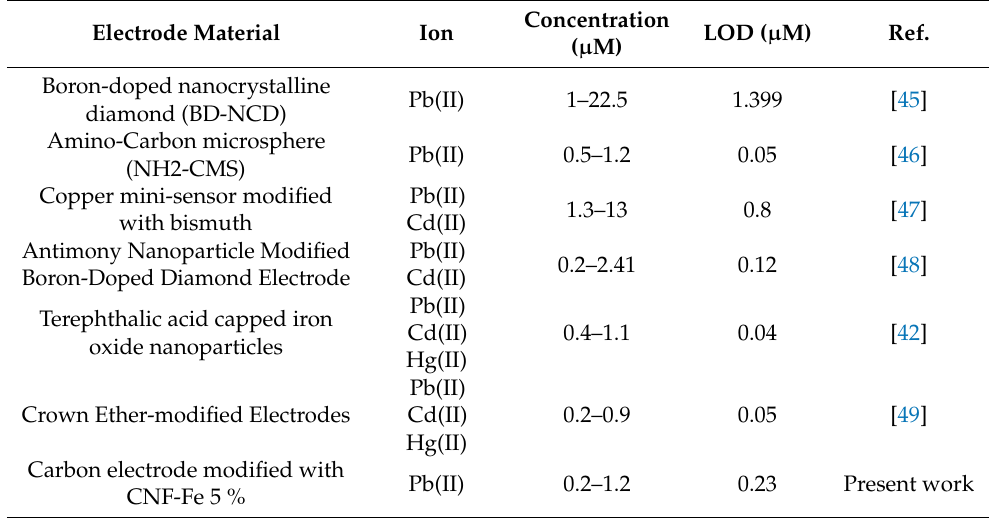
Table 2. Comparison of modified electrodes for the determination of